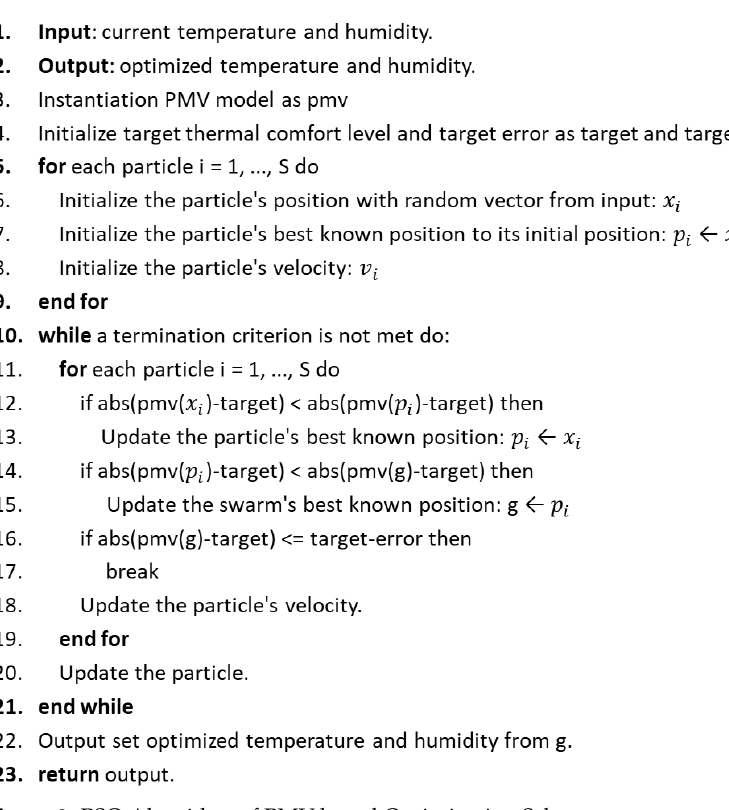
Figure 4. Sequence Diagram of Proposed System Operation for Efficient Thermal Comfort. 4. Implementation and Result The structure of our proposed system is implemented as shown in Figure 5. Indoor or outdoor data is generated in a virtual smart home environment, and the generated data is transmitted to the edge computing platform by sensors, which are IoT devices. The data collected from sensors would feed to the optimization engine as input. The optimization